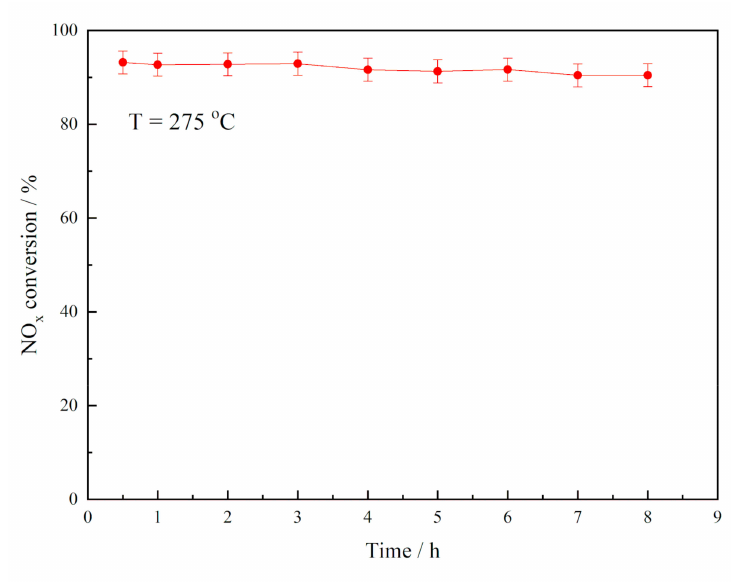
Figure 12. The denitration activity of Mn-Ce / MCM-41(0.2) under continuously mixed